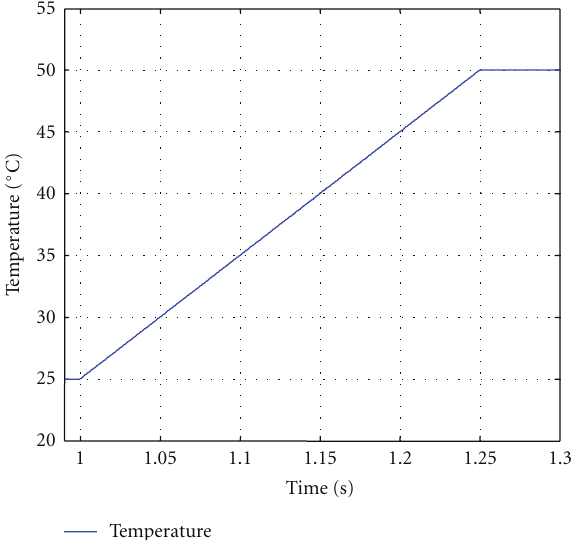
Figure 18: Slow change of temperatures from 25 ◦ C to 50 ◦ C.